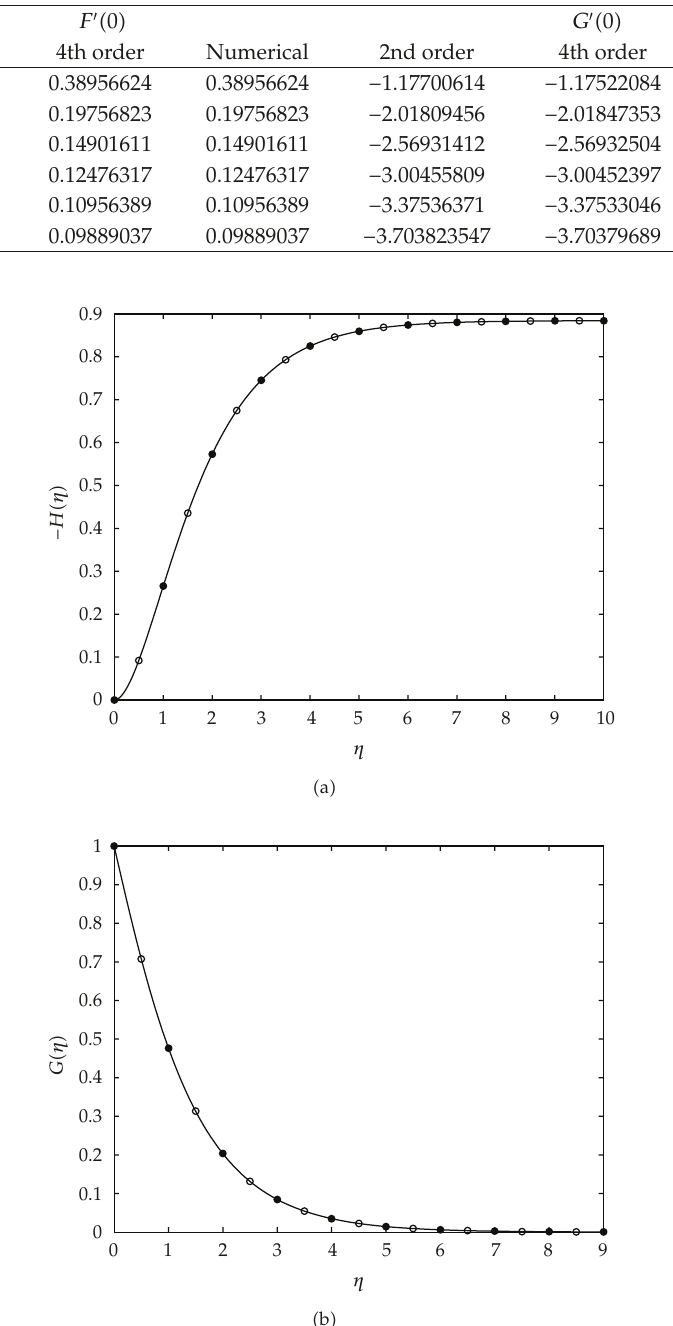
Table 6: Flow parameters F (cid:4) (cid:6) 0 (cid:7) and G (cid:4) (cid:6) 0 (cid:7) at di ff erent orders for the SLM approximations when L (cid:10) 20, N (cid:10) 120 for di ff erent m values when s (cid:10) 1.